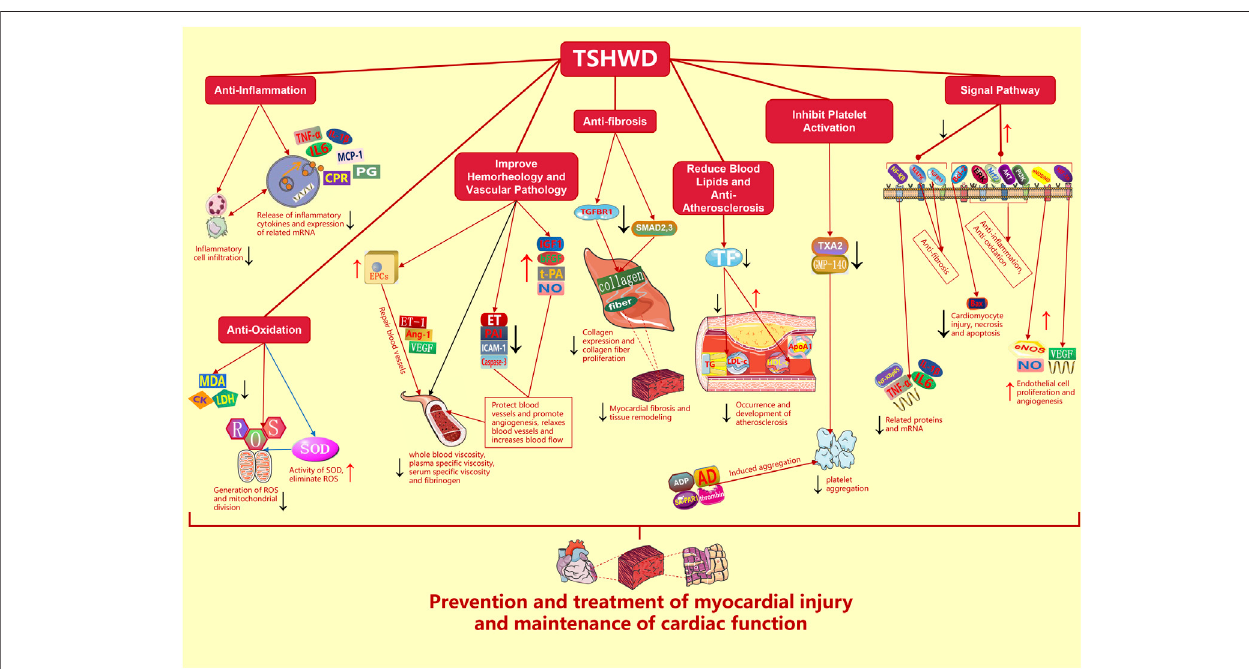
FIGURE 2 | Mechanisms of THSWD in prevention and treatment of MI (THSWD: Taohong Siwu decoction, MI: myocardial injury, TNF- α : tumor necrosis factor- α , IL-1 β : interleukin-1 β , IL-6: interleukin-6, IL-8: interleukin-8, ROS: reactive oxygen species, MCP-1: monocyte chemoattractant protein-1, LPS: lipopolysaccharide, NF- κ B: nuclear factor- κβ , hs-CRP: hypersensitive C-reactive protein, SOD: superoxide dismutase, PG: prostaglandins, LDL: low density lipoprotein, CK: creatine kinase, LDH: lactate dehydrogenase, MDA: malondialdehyde, bFGF: basic fi broblast growth factor, IGF-1: insulin-like growth factor-1, EPCs: endothelial progenitor cells, ET-1: endothelin-1, Ang-1: angiopoietin-1, VEGF: vascular endothelial growth factor, PAI: plasminogen activator inhibitor, ICAM-1: intercellular adhesion molecule-1, t-PA:tissueplasminogenactivator,Caspase-3:cysteineaspartateprotease-3,TGFBR1:transforminggrowthfactor1receptor,SMAD2,3:thephosphorylationofsignal transduction protein 2,3, TC: total cholesterol, TG: triglyceride, LDL-c: low density lipoprotein-C, HDL-c: high density lipoprotein-C, TF: tissue factor, ApoA1: apolipoprotein A1, PLT: platelets, ADP: adenosine diphosphate, AD: adrenaline, TXA2: thromboxane A2, GMP-140: granule membrane protein-140, SA-PAR1: selective agonists of protease-activated receptor-1, HIF-1 α : hypoxia inducible factor-1 α , eNOS/NO: endothelial nitric oxide synthase/nitric oxide, Bcl-2: B lymphocyte tumor-2, Bax: Bcl-2-associated X protein, Nrf2: NF-E2 related factor 2, PI3K: phosphatidylinositol 3-kinase, ERK: extracellular regulated protein kinases, MAPK: mitogen-activated protein